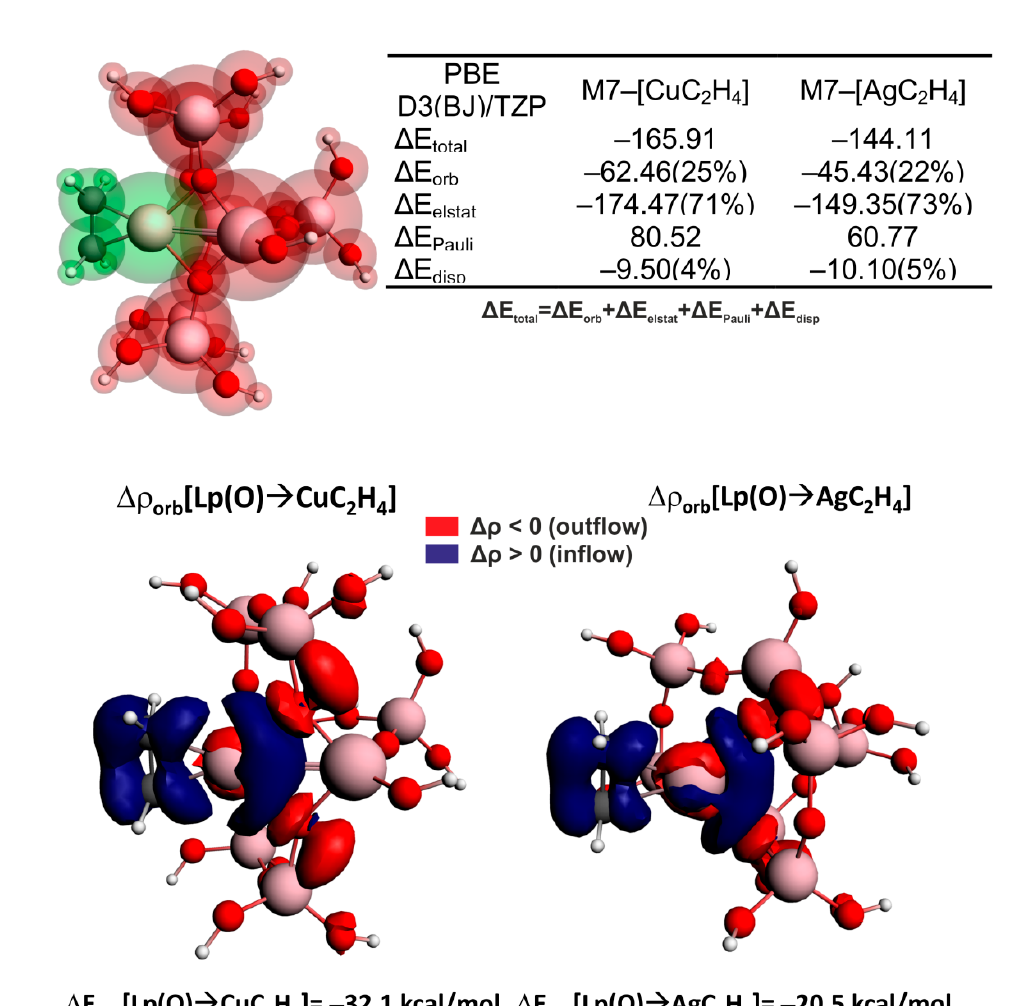
Figure 7. The results of ETS-NOCV/PBE-D3(BJ)/ZORA/TZP energy decomposition describing [M7]–[Cu/AgC 2 H 4 ] bonding. Additionally, the most relevant NOCV-based deformation density channels ∆ ρ orb (1+2), together with the corresponding energies Δ E orb (1+2), are presented.